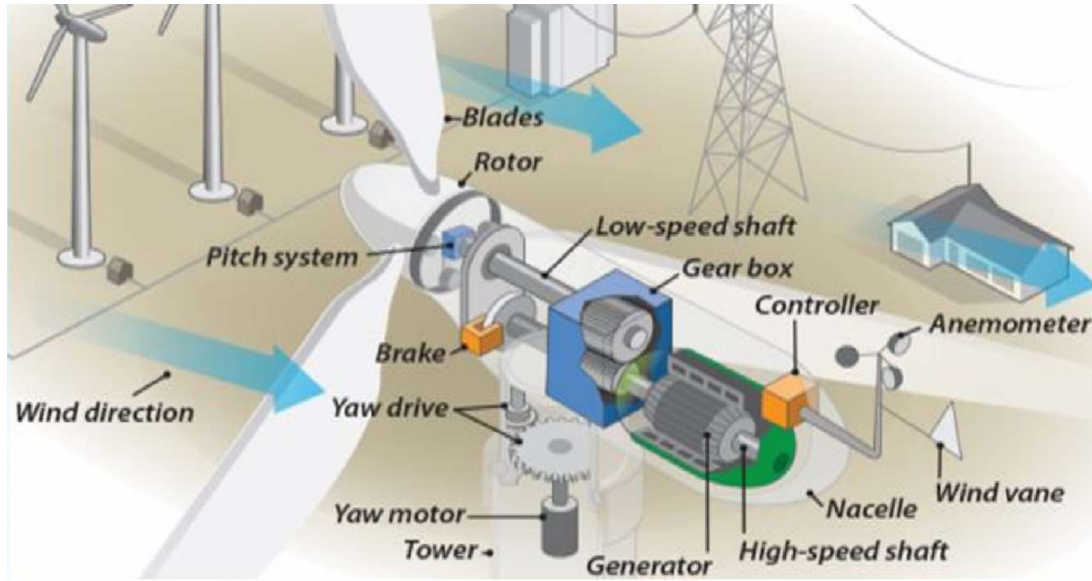
Figure 6. The various components of a wind turbine